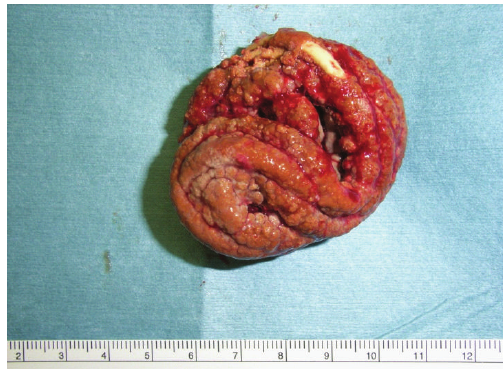
Figure 2: The convoluted stone-like foreign body in the bladder.